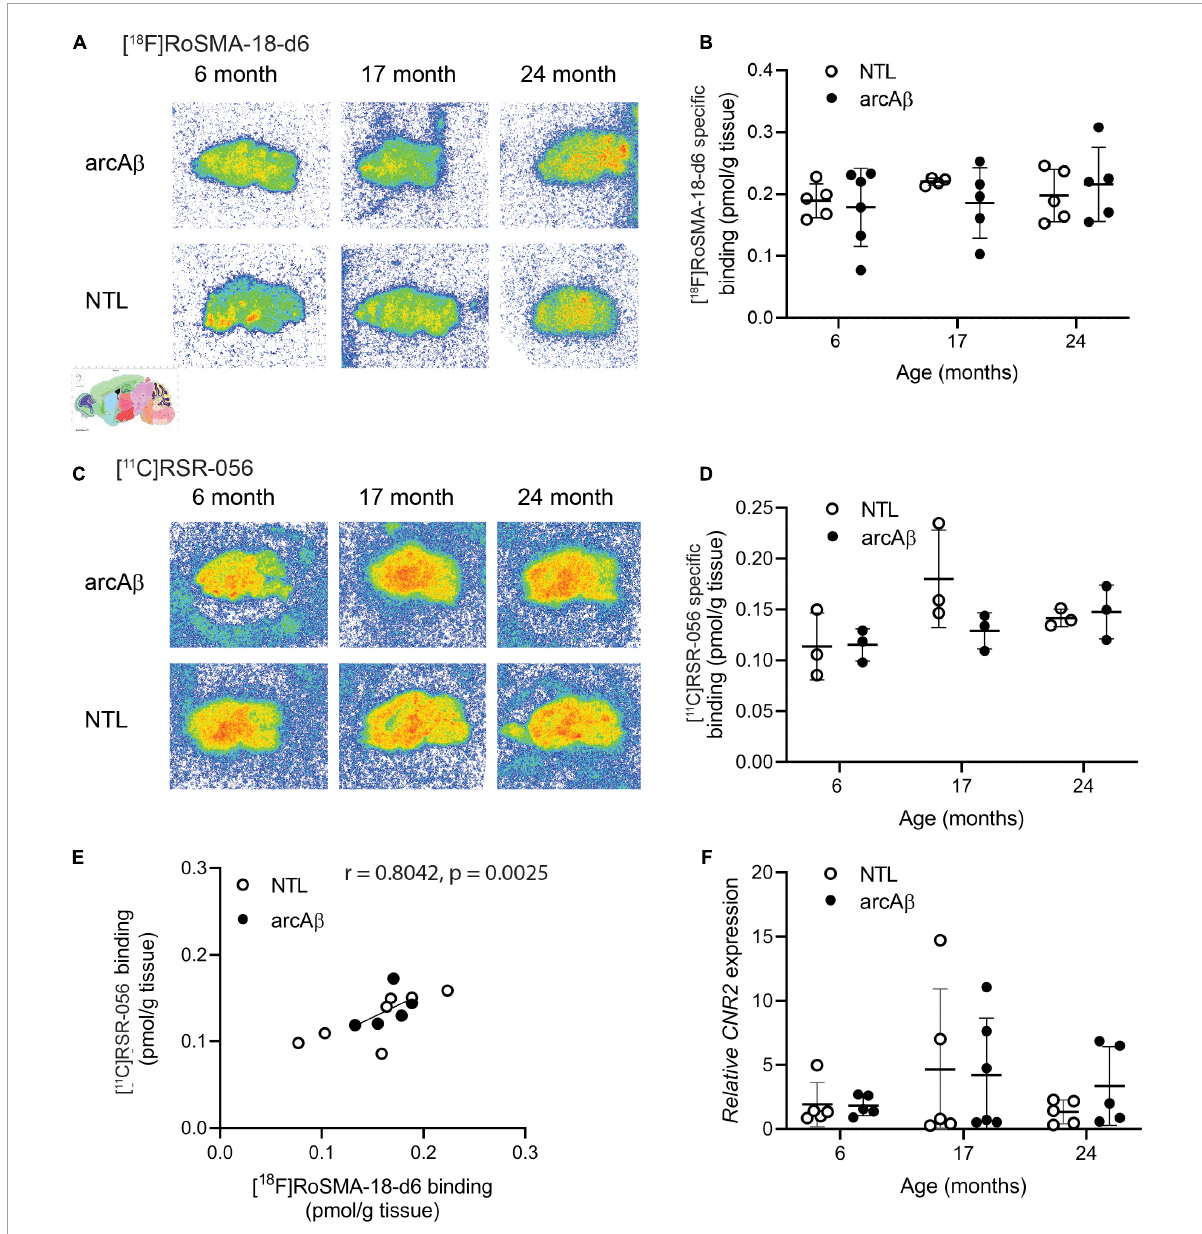
FIGURE4 Comparable regional [ 18 F]RoSMA-18-d6 and [ 11 C]RSR-056 specific binding in the brains of arcA β and non-transgenic mice at 6, 17, and 24 months of age. (A) Representative [ 18 F]RoSMA-18-d6 (0.5 nM) autoradiographic images (total binding) of sagittal brain sections of arcA β and non-transgenic littermate (NTL) mice at 6 months of age ( n = 5, 6), 17 months of age ( n = 4, 5), and 24 months of age ( n = 5, 5). (C) Representative [ 11 C]RSR-056 (2 nM) autoradiographic images (total binding) of sagittal brain sections of arcA β and non-transgenic littermate (NTL) mice at 6 months of age ( n = 3, 3), 17 months of age ( n = 3, 3), and 24 months of age ( n = 3, 3). (B,D) Quantification of specific binding of [ 18 F]RoSMA-18-d6 (0.5 nM), and [ 11 C]RSR-056 (2 nM) in the whole sagittal brain slice in panels (A,C) . Two-way ANOVA, arcA β vs. NTL. (E) Robust correlation between specific binding of [ 18 F]RoSMA-18-d6 (0.5 nM) and [ 11 C]RSR-056 (2 nM) autoradiograms on arcA β and NTL mouse brain hemispheres (Spearman rank, r = 0.8042, p = 0.0025). (F) Cnr2 expression in arcA β and NTL mouse brain hemisphere homogenates at 6 months of age ( n = 5, 5), 17 months of age ( n = 5, 6), and 24 months of age ( n = 5, 5).